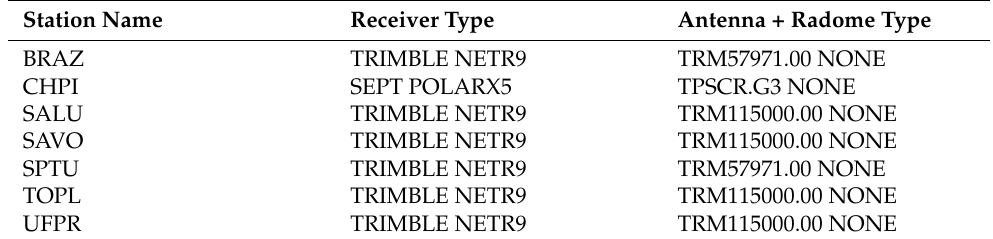
Table 4. The GNSS receivers and the antenna + radome types of the low latitude stations.